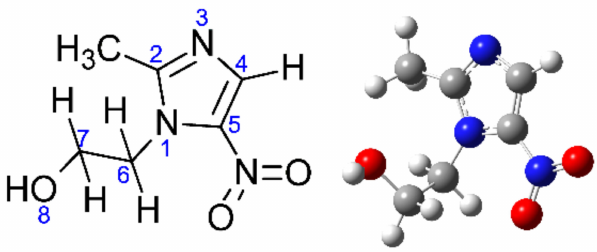
Figure 1. The structure of metronidazole with atom numbering (left) and a 3D structure